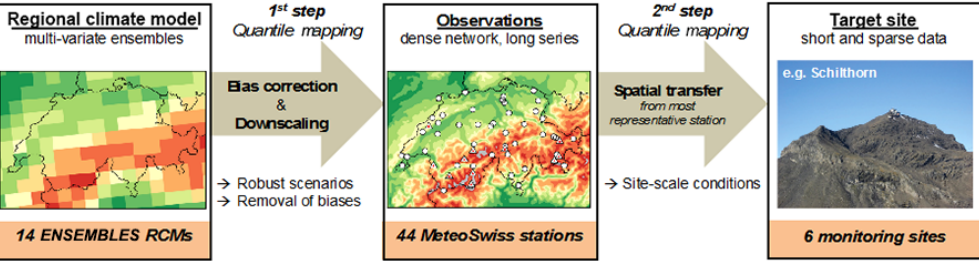
Figure 1. Schematics of the two-step procedure used for the generation of climate scenarios at the six monitoring sites. Figure adapted from Rajczak et al.